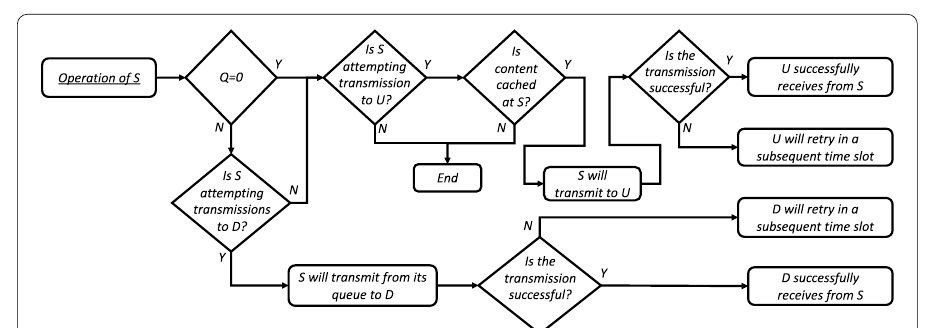
Fig. 3 Operation of S when user U requests a file f from external